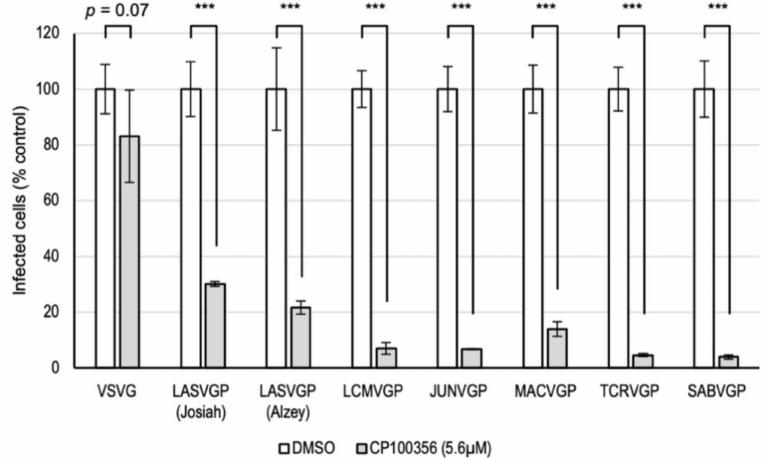
Figure 5. Broad-spectrum inhibitory effects of CP100356 against different mammarenaviruses. Vero cells treated with CP100356 or DMSO were infected with pseudotyped viruses harboring vesicular stomatitis virus glycoprotein (VSVG), LASV glycoprotein (LASVGP) (strain Josiah), LASVGP (strain Alzey), LCMVGP, JUNVGP, MACVGP, TCRVGP, or SABVGP, respectively. Infection was evaluated at 20 h post-infection by counting the number of cells expressing green fluorescent protein relative to the number of nuclei in the wells. Welch’s t-test was used to compare the two groups, and p values are indicated; *** p < 0.001. The values indicate means ± standard deviation of representative experiments in biological triplicates from two independent